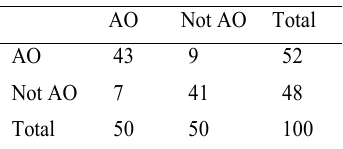
Table 7. Confusion matrix of the best binary CART ® autumn olive classified map.